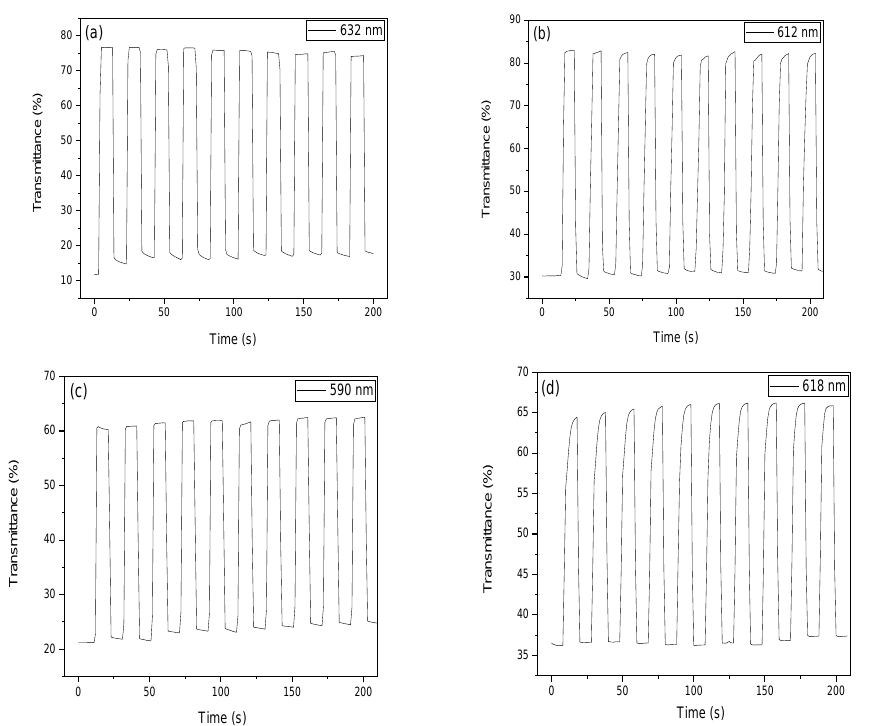
Figure 5. Optical response of ( a ) Fe-Tt ( b ) Fe-TtE ( c ) Fe-TtPh and ( d ) Fe-TtB films to the periodic cycling of the applied voltage between 0 and 1.4 V. Absorption recorded at indicated wavelengths.